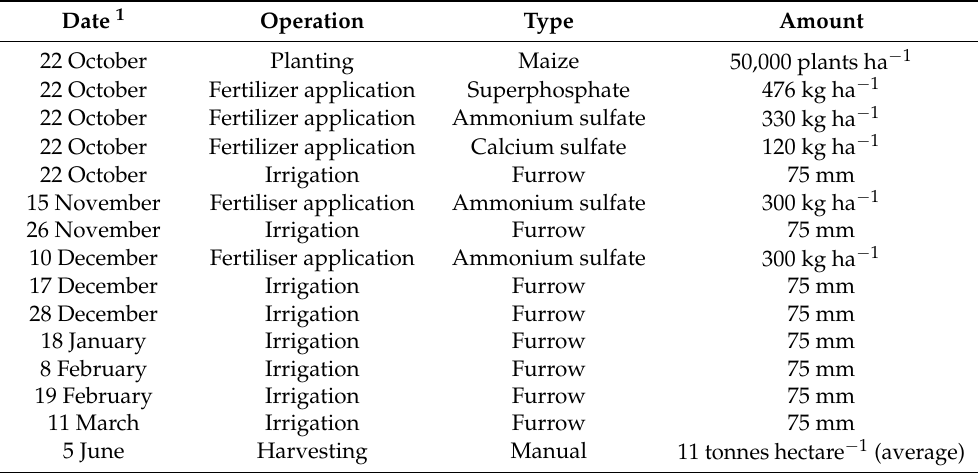
Table A2. Showing the agricultural management plan used during the study period (table obtained from [32]).